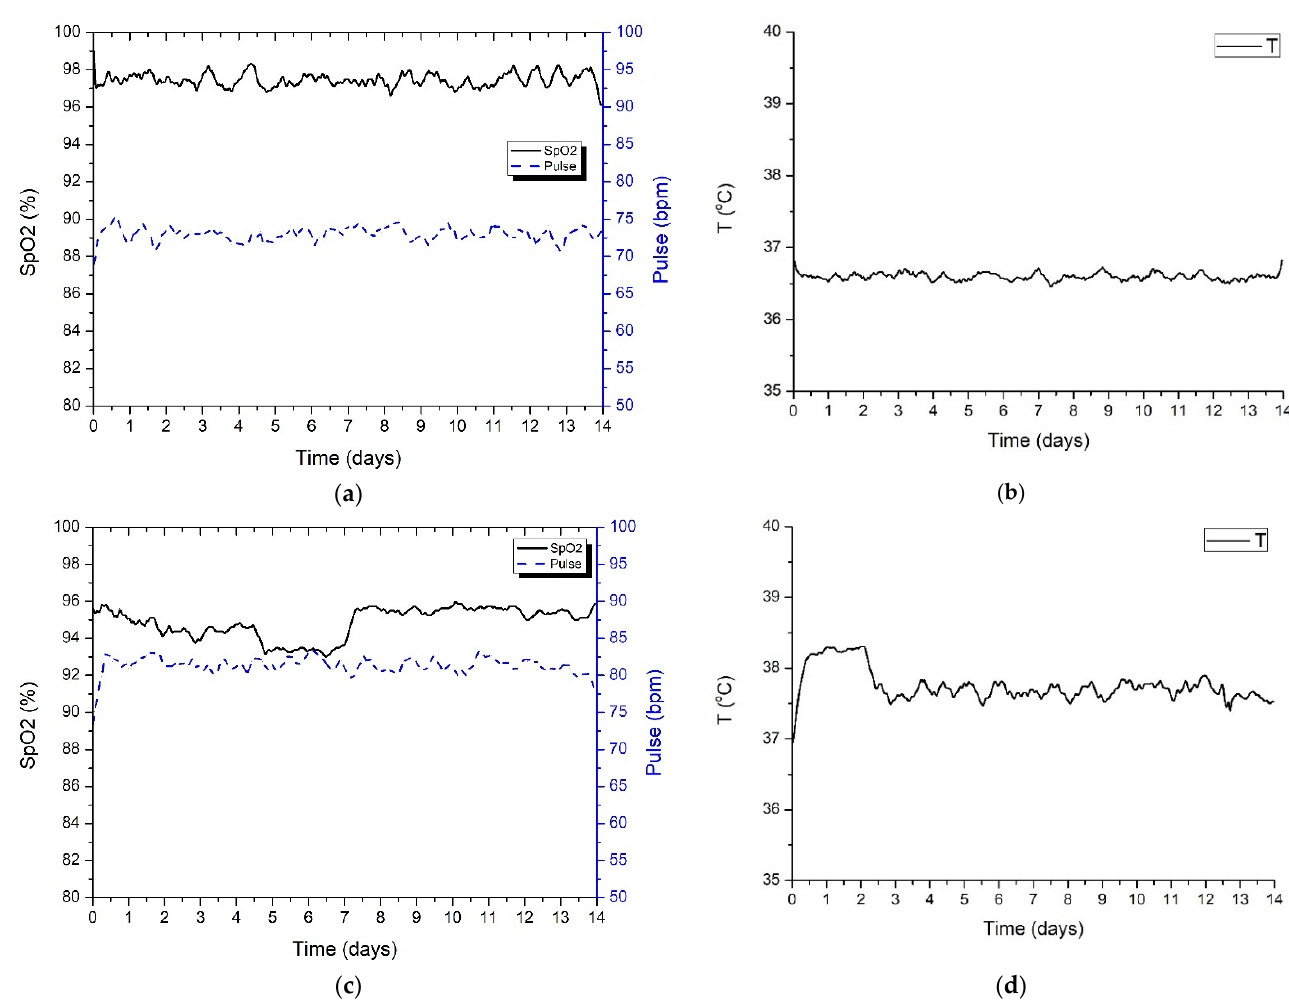
Figure 11. Patients’ vital signs measurement obtained from the IoT wearable device. ( a ) SpO 2 and pulse (Patient A). ( b ) Body temperature (Patient A). ( c ) SpO 2 and pulse (Patient B). ( d ) Body temperature (Patient B).